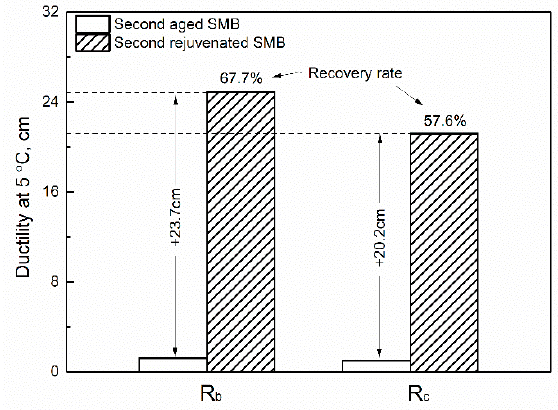
Figure 1. Effect of rejuvenating systems on the ductility of second-aged SMB.